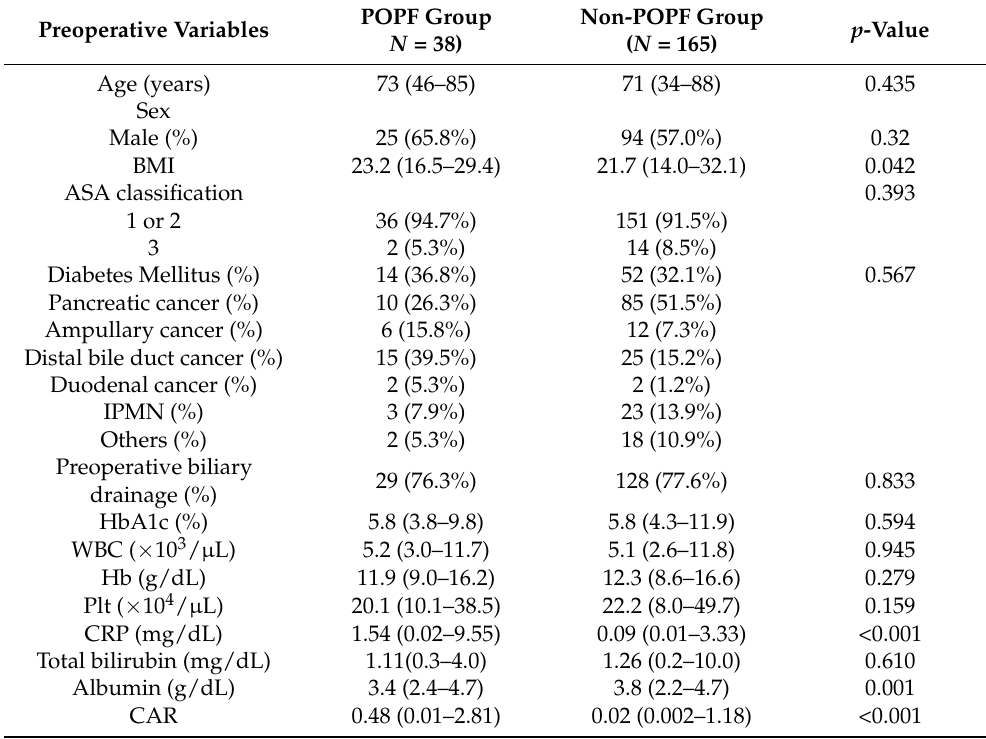
Table 1. Preoperative variables in patients with and without POPF.